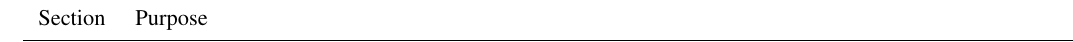
Table 2. Overview of the survey.